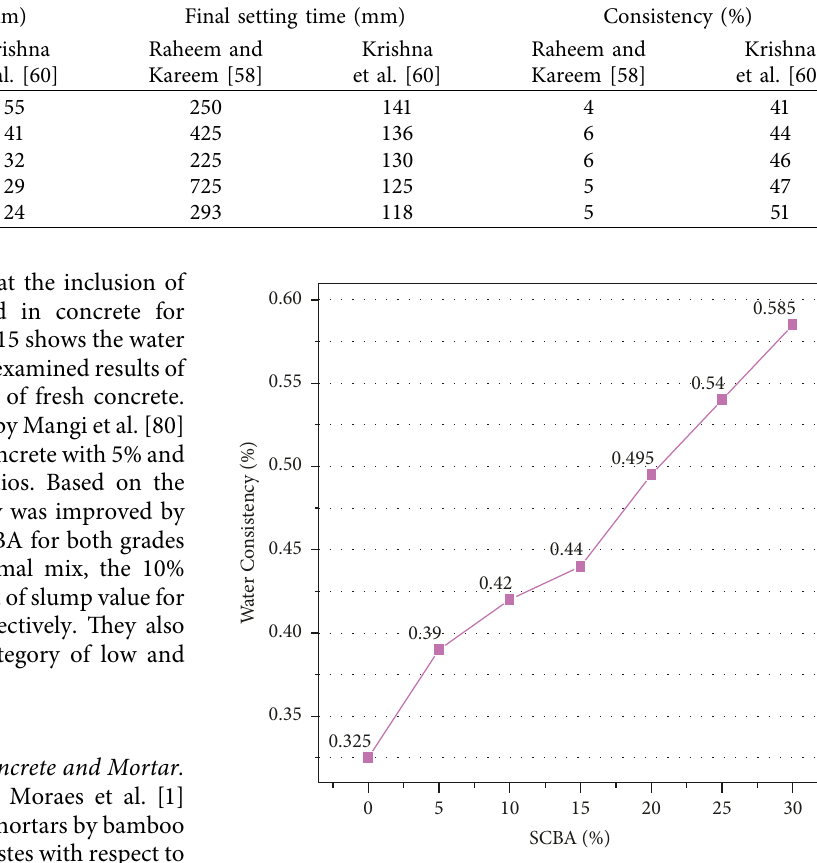
Figure 15: Water consistency of fresh concrete.